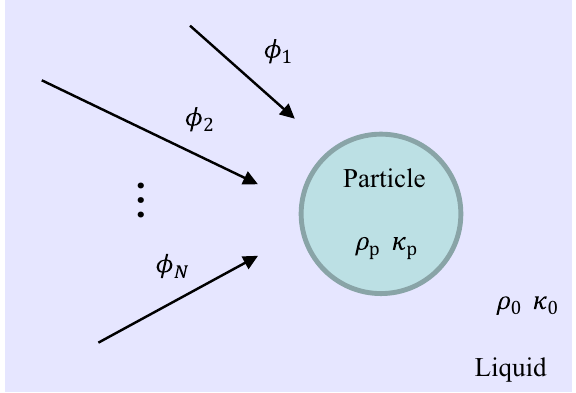
Figure 1. Schematic of the analytical model. Multiple incoming acoustic waves with potentials, φ 1 , . . . , φ N , of the different angular frequency, ω 1 , . . . , ω N , are incident on a small compressible spherical particle of compressibility κ p and density ρ p . Such acoustic waves are synthesized in space and scatter at the